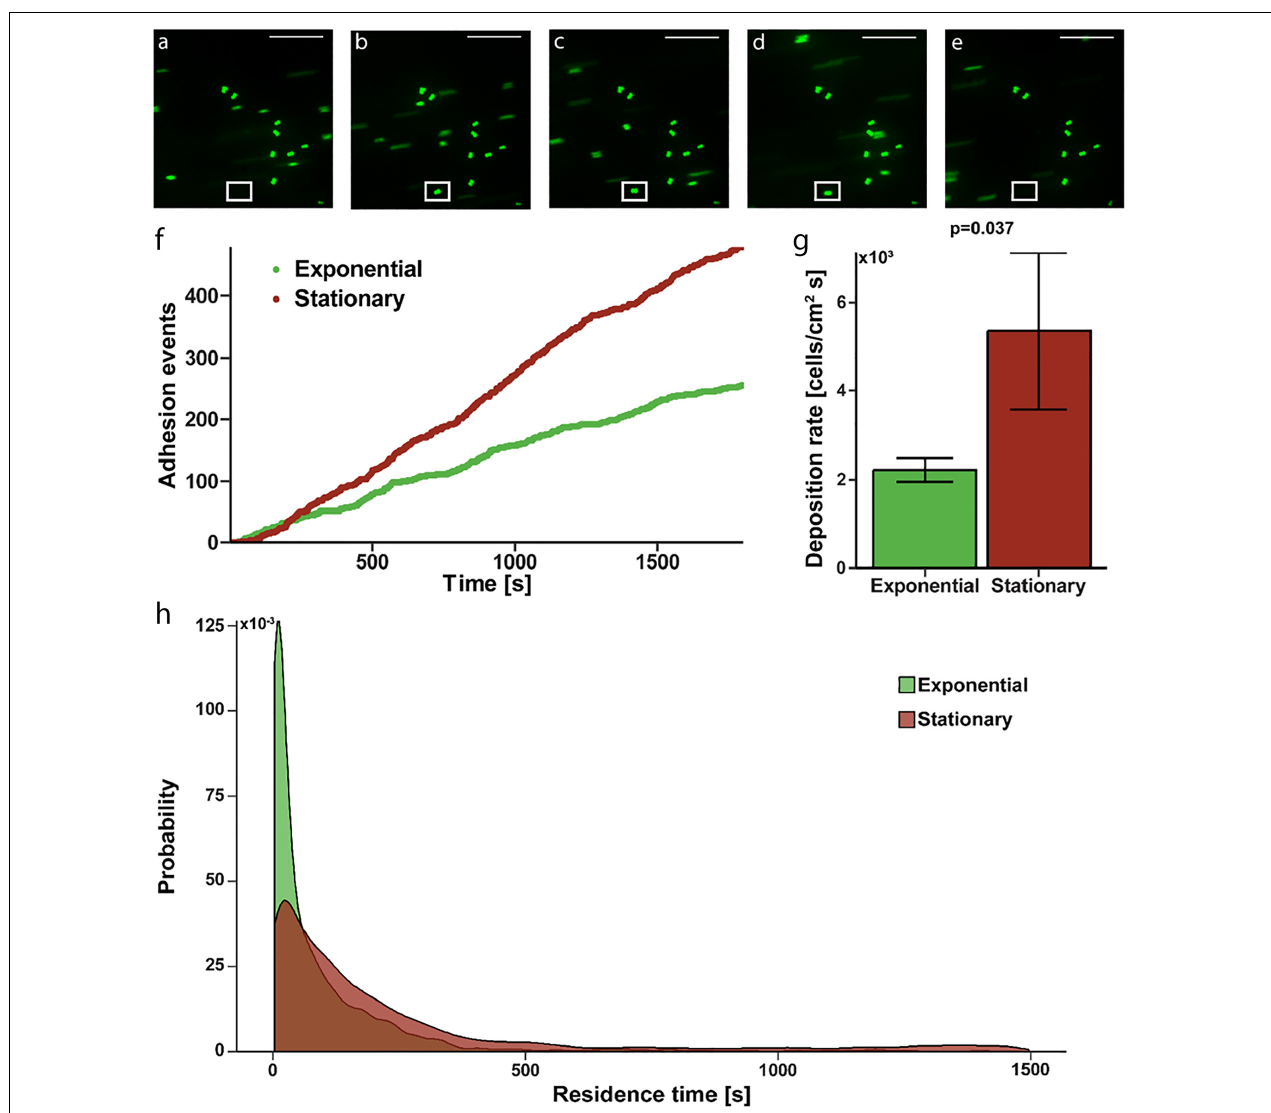
FIGURE 2 | Adhesion of S. epidermidis to a fibrinogen coated surface under continuous flow. (A–E) Representative sequential images of fluorescently labeled S. epidermidis (green) captured every 3 s with absence of a cell in white frame in panel (A) , adhesion event demonstrated in frames (B–D) and subsequent absence in panel (E) representing a release event. Time between frames (B–E) represents the residence time of that single cell. Scale bar = 20 µ m. (F) Graphical representation of a single experiment of adhesion events over time for exponential (green) versus stationary phase (red). (G) Deposition rate of exponential versus stationary phase S. epidermidis for N = 10 paired experiments with duplicate measures. (H) Residence time probability distribution of exponential versus stationary phase S. epidermidis for all 10 paired experiments with duplicate measures.